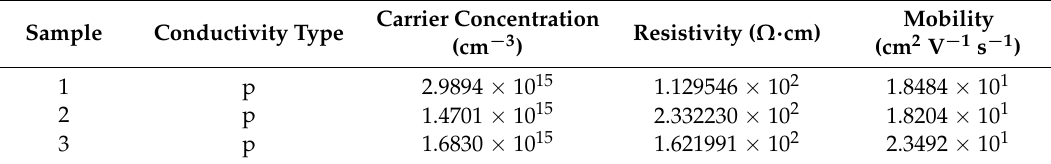
Table 2. The transport properties of GaSe single crystals (T = 295 K).